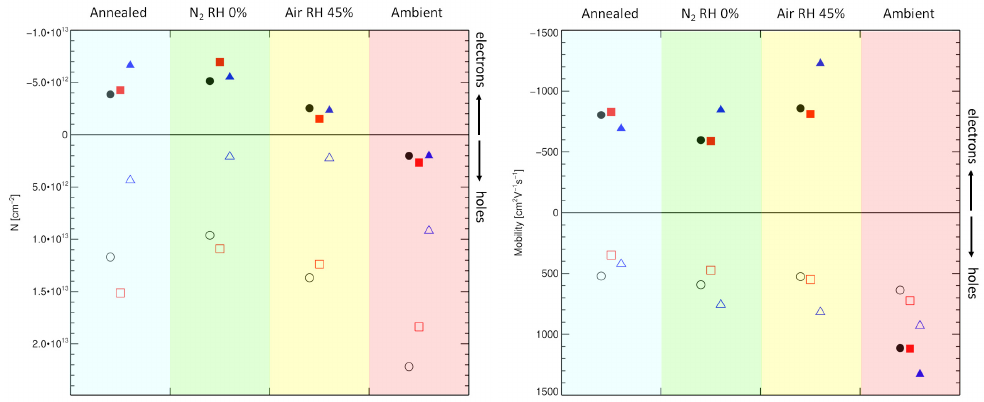
Figure 7. Free charge carrier density (left panel) and mobility (right panel) of MLG (filled symbols) and QFS-MLG (open symbols) with T Ar = 640 ◦ C (black circles), T Ar = 800 ◦ C (red squares) and T Ar = 1300 ◦ C (blue triangles) for different environmental conditions: after annealing in vacuum (Annealed), after being purged with dry N 2 for several days (N 2 RH 0%), after being purged with moist air (RH 45%) for several hours (Air RH 45%), and after being exposed to the ambient for several months